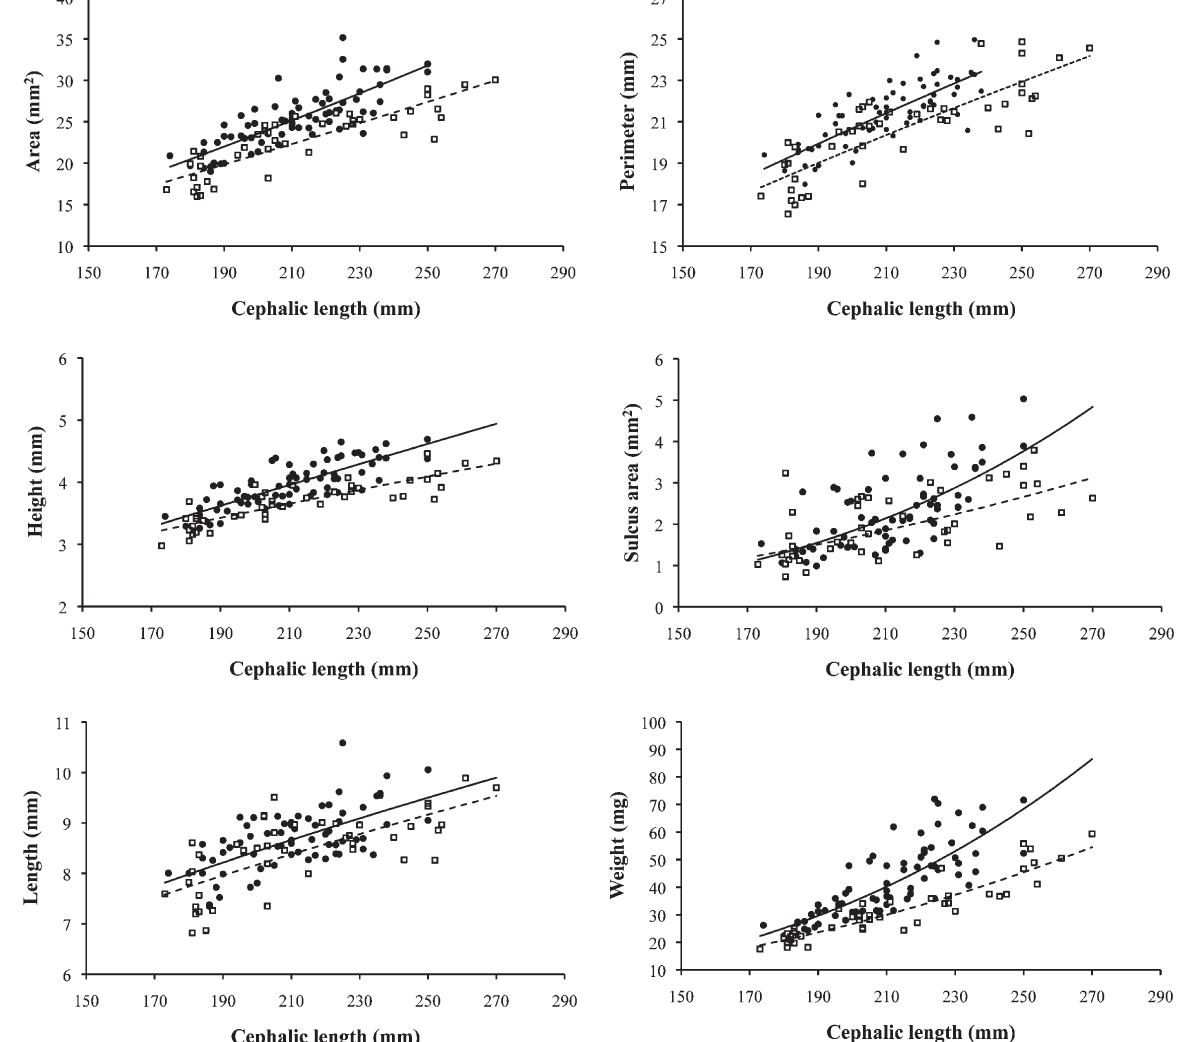
Fig. 6. – Power relationships between cephalic length and otolith variables in A. carbo (black dots) and A. intermedius (white